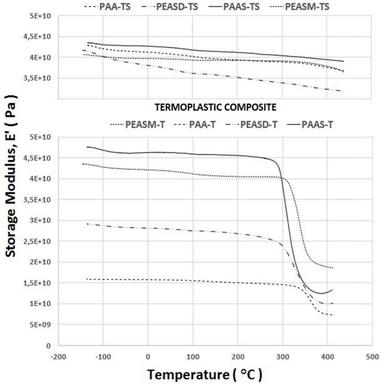
The storage modulus curves of the advanced composites.